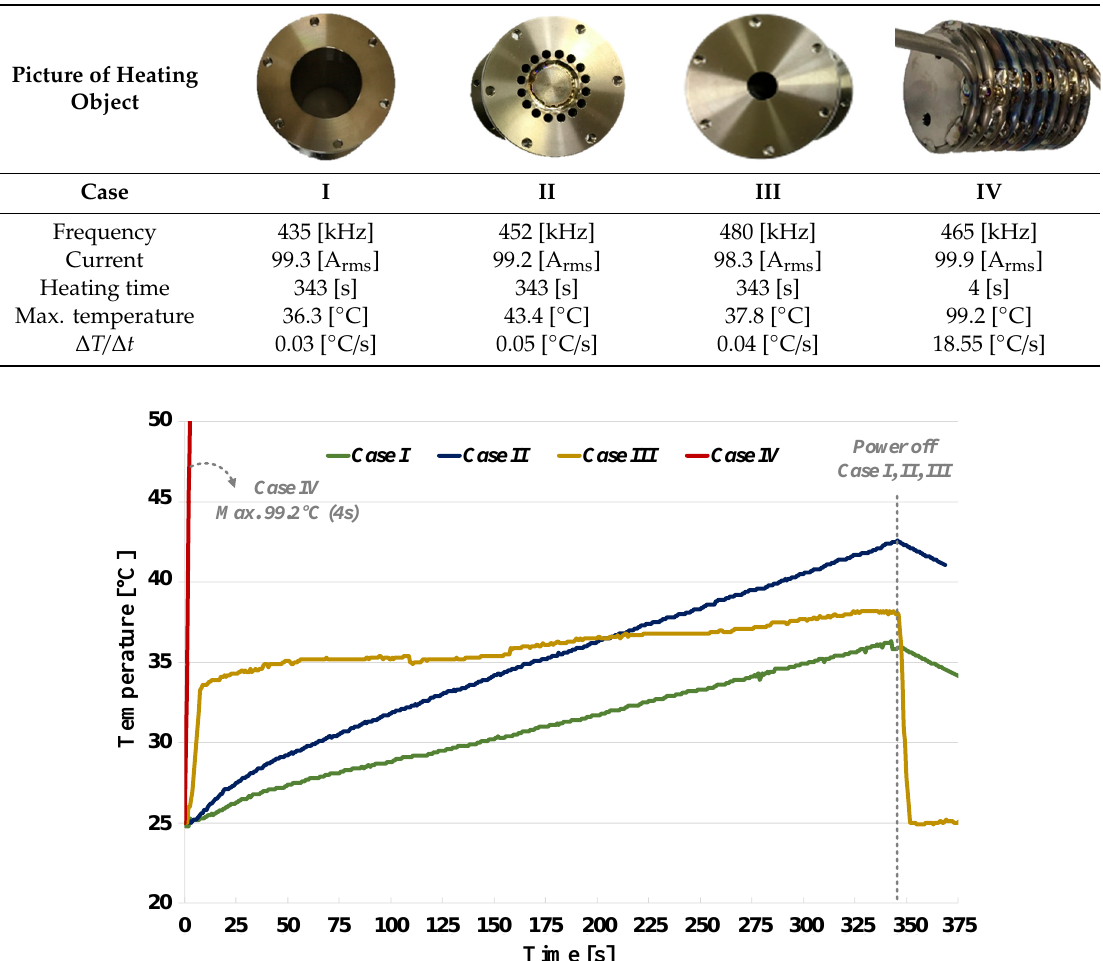
Figure 15. Experimental results of temperature rise for each Ti load case.